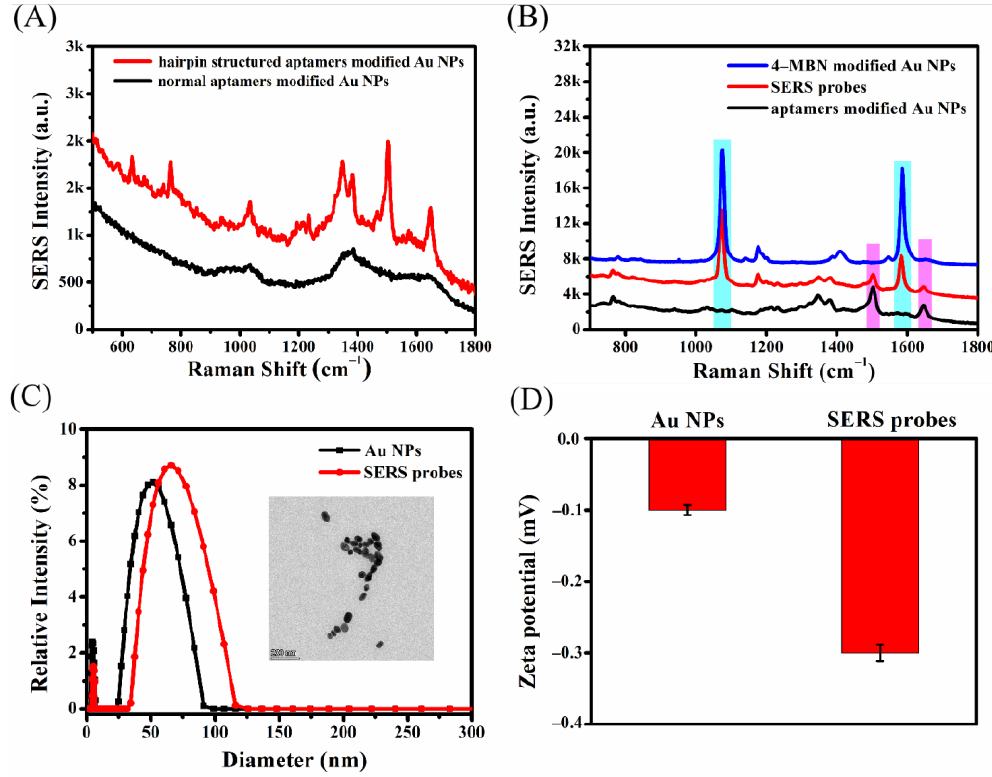
Figure 1. Results of the characterization of the SERS probe. ( A ) SERS spectra of normal aptamer- and hairpin-structured aptamer-modified Au NPs. ( B ) SERS spectra of 4-MBN-modified Au NPs, SERS probes, and hairpin-structured aptamer-modified Au NPs. ( C ) Size distribution of Au NPs and SERS probes (main panel) and a representative TEM image of Au NPs (inset panel). ( D ) Zeta potentials of Au NPs and SERS probes.